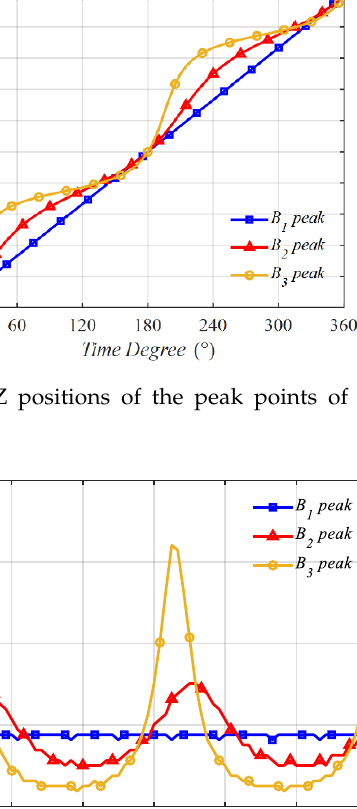
( , ) B z t ( , ) B z t ( , ) B z t , 2 , and 3 varying with the time